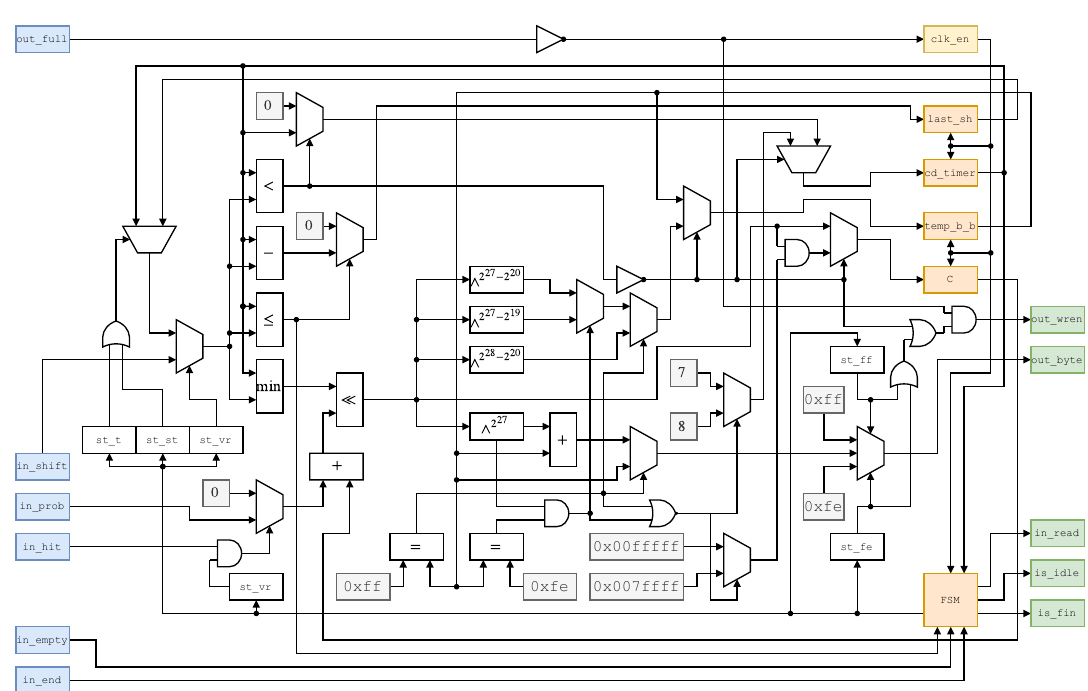
Figure 11. MQ-coder last stage. It interfaces with two FIFOs, reading updates from the previous stage and making sure space is available at the output to send bytes out.